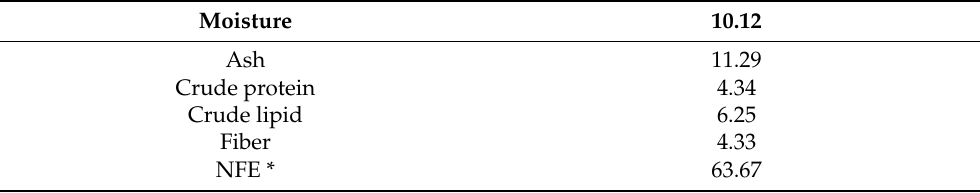
Table 2. Approximate composition (%) of Agaricus blazei spent substrate. Moisture